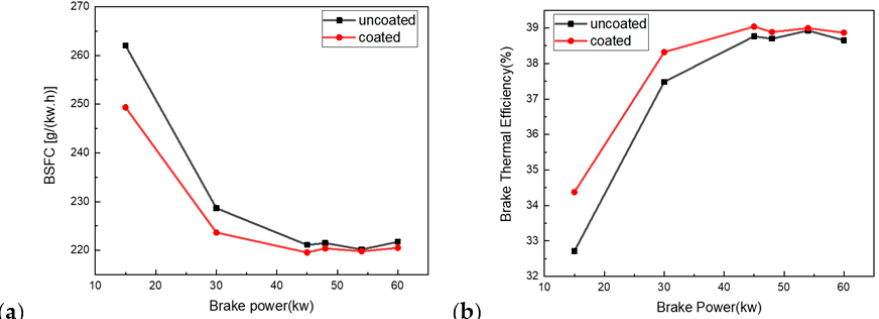
Figure 16. ( a ) brake power vs. brake specific fuel consumption; ( b ) brake power vs. brake thermal efficiency. Red line indicates the test results of diesel engine sprayed with YSZ coating, and black line indicates the test results of original engine.